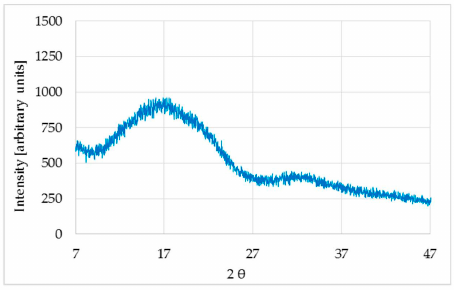
Figure 1. X-ray diffraction diagram of the untreated sample. Table 2. Angular values of diffraction maxima and reticular spacing in the sample. Sample